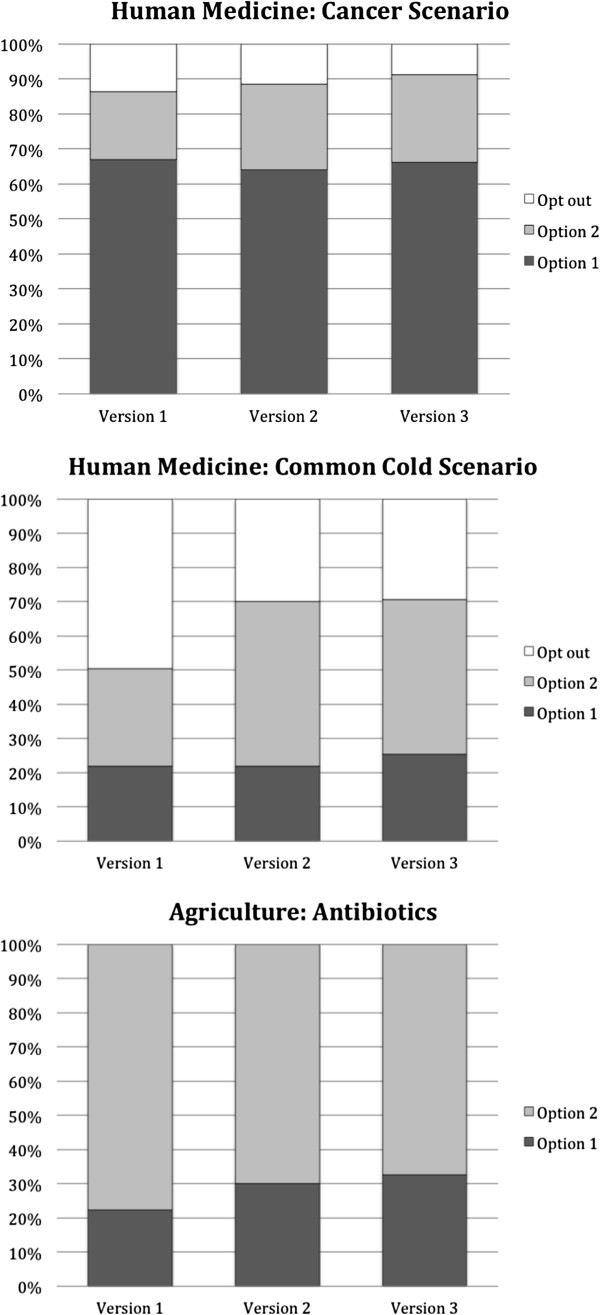
Results of choice task for the scenarios related to human medicine (cancer and common cold) and agriculture (antibiotics) for all three versions of the scenarios. Versions 1–3 represent comparisons between pairs of drugs that varied in their relative effectiveness and environmental impact (see Tables 2 and 3). Note that Option 1 was always more effective, while Option 2 was always more environmentally friendly.